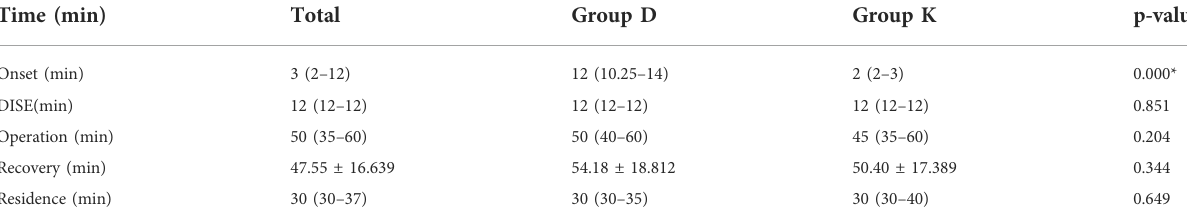
TABLE 2 Time for each procedure.